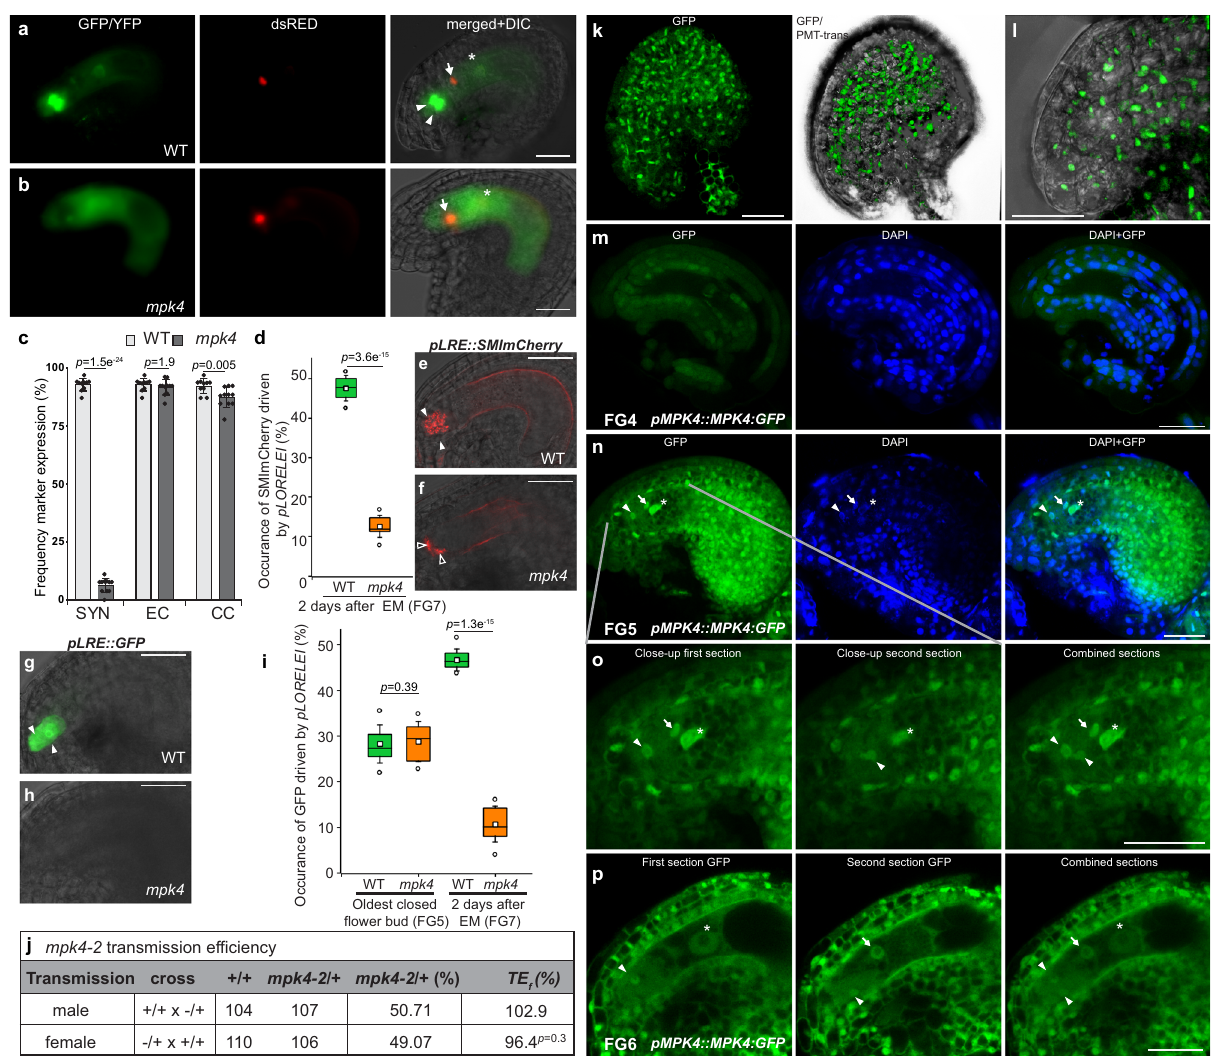
Fig. 2 Premature synergid degeneration at the molecular level, and MPK4 localization in the embryo sac. a – c Expression of the female-gametophyte reporter (FGR7.0) in ( a ) WT and ( b ) mpk4 . c Frequency of FGR7 .0/ + expression in WT ( n = 321) and mpk4 ( n = 285) ovules was determined. Error bars show ± SD. d – i Expression of the LORELEI -reporter ( pLRE ) coupled to the Golgi-retention peptide sequence SMImCherry ( d – f ) and a single GFP ( g – i ). The expression of pLRE::GFP/- was analyzed in the oldest-closed fl ower bud (FG5 stage) (WT, n = 326; mpk4 , n = 240) and 48 h after emasculation (WT, n = 328; mpk4 , n = 251; FG7 stage). pLRE::SMImCherry/- was analyzed 48 h after emasculation (WT, n = 293; mpk4 , n = 257). Boxes represent the 25th and 75th percentiles, and the inner rectangle highlights the median, whiskers show the SD, and outliers are depicted by dots (Min/max range). j Transmission analysis of mpk4 . Transmission ef fi ciency (TE f ) indicates the transmission of mpk4 through the male and female gametophyte. k – p Representative images of MPK4:GFP expression and localization in the sporophytic ovule tissue ( k – l ) and at the female gametophytic developmental stages FG4, FG5, FG6 ( m – p ). k – l Depicted are maximum projections of Z-stacks, with a focal plane distance of 2 µ m within a total range of about 30 µ m, animated 3D-projection is provided in Supplementary movie 5. m – p pMPK4::MPK4:GFP -expressing line was analyzed, accompanied by the nuclei-staining dye DAPI. Negative control Supplementary Fig. 1l. Experiments were repeated three times with similar results and presented are representative images. c , d , i , j Statistical signi fi cance was analyzed by one-way ANOVA. Source data and further statistical analysis are provided in the source data fi le. White arrowhead, synergid; black arrowhead, degenerating synergid; white arrow, egg cell; white asterisk, central cell nucleus; black asterisks, polar nuclei.